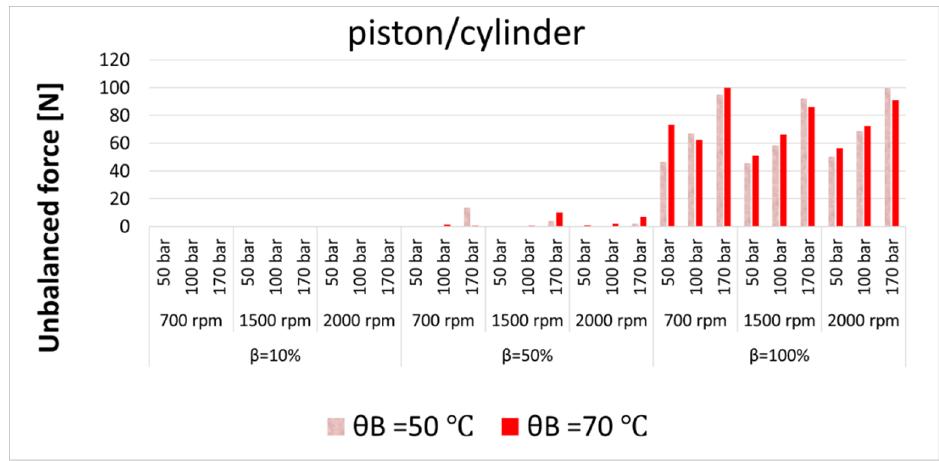
Figure 29. Unbalanced forces in the piston/cylinder interfaces at different operating conditions.